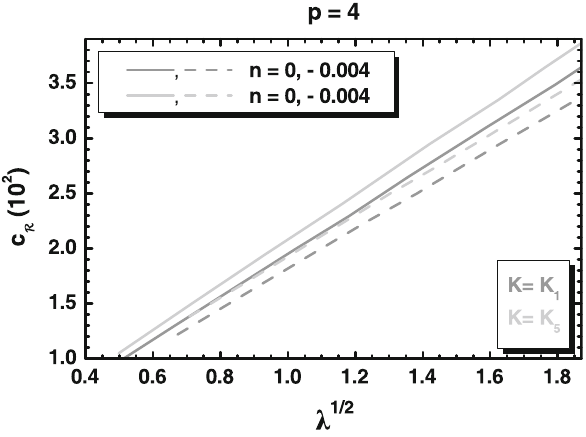
√ λ for p = 4 and various n ’s and K ’s. The conventions adopted for the various lines are also